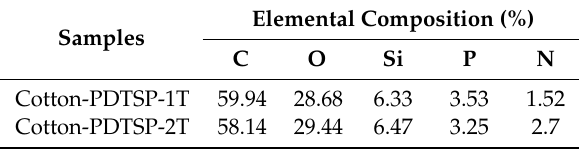
Figure 5. XPS spectra of char residue of PDTSP coated cotton ( a ); High-resolution C 1s, O 1s, Si 2p, P 2p, and N 1s spectra for the char residue of Cotton-PDTSP-2T ( b ). Table 3. Elemental composition in the char residue.